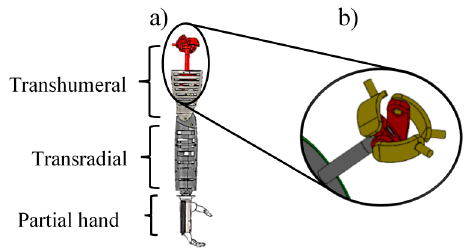
Figure 11. Degrees of amputation: ( a ) Schwartz classification. ( b ) Spherical manipulator mechanism.